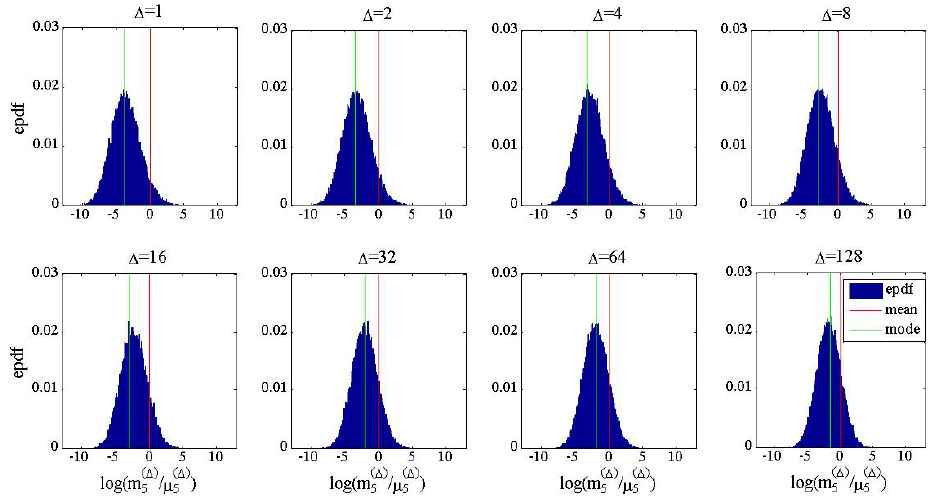
Fig. 4. The epdf of the sample fifth moment estimated from log-normal time series averaged locally over different timescales 1